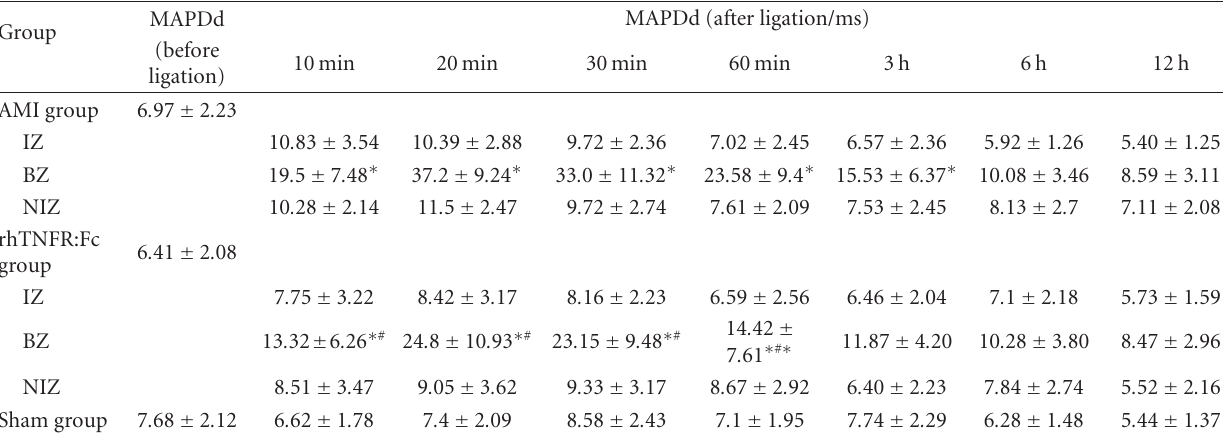
Table 1: MAPDds of di ff erent zones (cycle length = 167